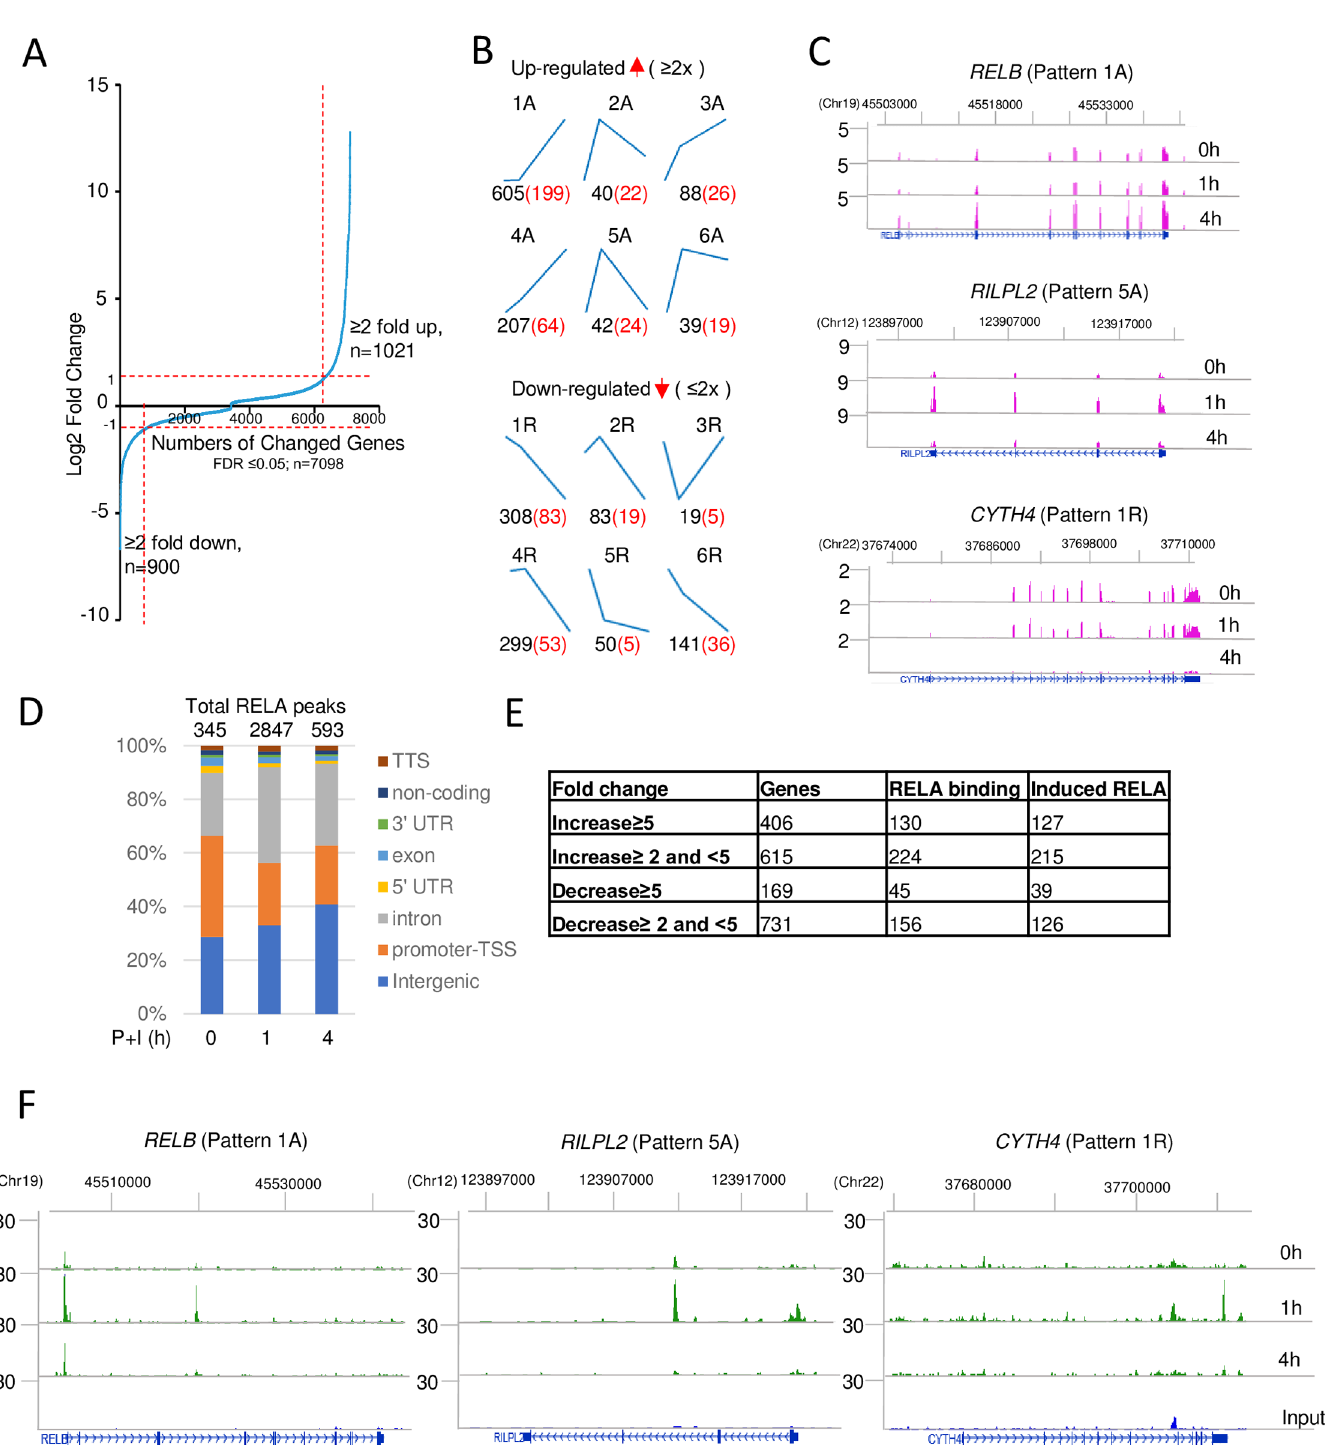
Fig 1. Inducible transcription and RELA binding in activated B lymphoma cells. BJAB human B lymphoma cells were treated with P+I for 1 or 4 h, followed by analyses of inducible transcription and RELA binding by RNA-Seq and ChIP-Seq, respectively. (A) Gene expression changes at either 1 or 4 h post activation compared to unactivated cells. Two biological replicate experiments were carried out, and differential gene expression was analyzed using EBSeq. (B) Inducibly up- or down- regulated transcripts were partitioned into 6 patterns (middle panel, top, or bottom, respectively) by k -means clustering (see also S1B–S1E Fig). Each graph represents the gene expression pattern at 0, 1, and 4 h. Numbers of genes in each pattern are indicated below in black. The letter “A” after a pattern number indicates genes that are activated by P+I, and the letter “R” indicates genes that are repressed by P+I. Red numbers identify putative RELA target genes according to criteria discussed in the